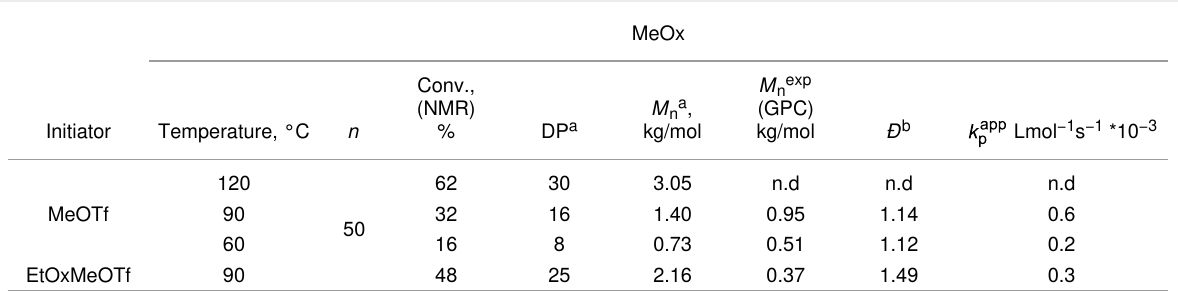
Table 1: Investigation of the cationic ring-opening polymerization of 2-methyl-2-oxazoline initiated with methyl triflate at 60 °C, 90 °C, and 120 °C and with 2-ethyl-3-methyl-2-oxazolinium triflate salt at 90 °C in DLG.